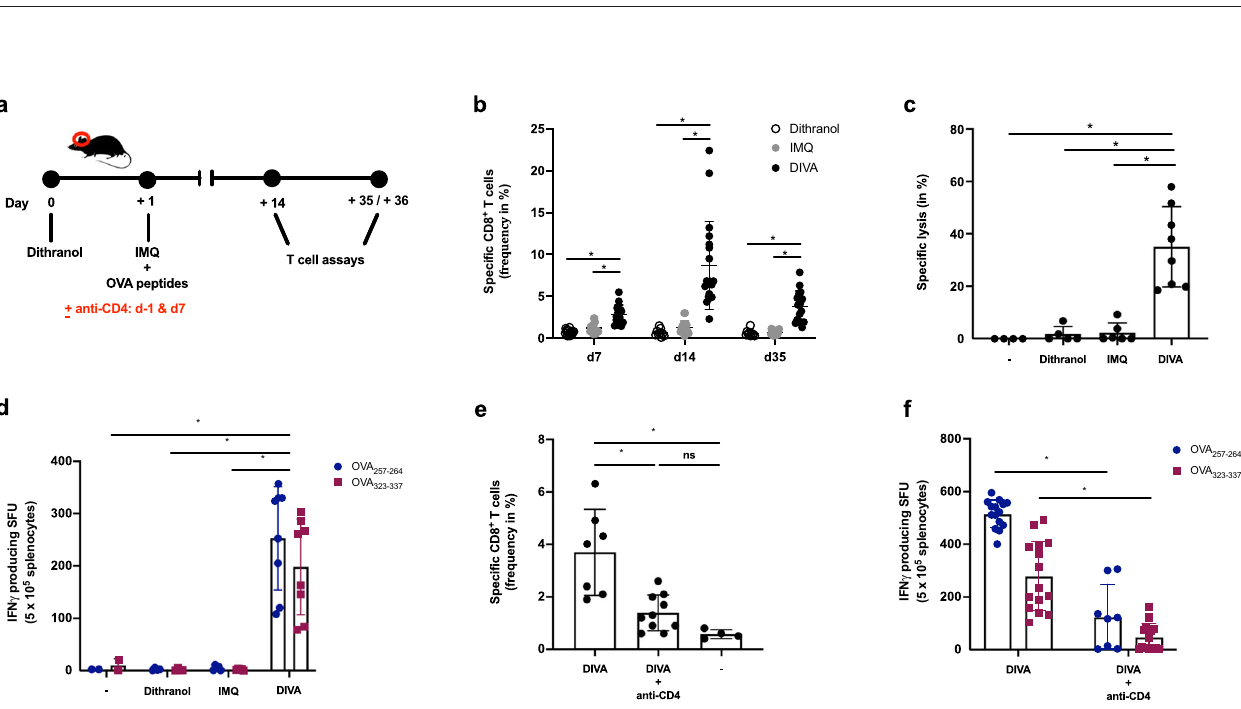
Fig. 2 DIVA generates memory CD8 + and CD4 + T cell responses. a Schematic overview of the DIVA protocol for the generation of a memory immune response. C57B6/J wildtype mice were immunized on both ears with dithranol (day 0) and IMQ together with OVA 257 – 264 & OVA 323 – 337 (stirred in of fi cinal cremor basalis, day 1) on 2 consecutive days, treated with the single agents or left untreated (untreated control). b The frequency of OVA 257 – 264 speci fi c CD8 + T cells in the blood was assessed on day 7, 14, and 35 ( n = 9 – 19). c On day 36, the in vivo cytolytic activity was estimated 20 h after transfer of peptide-loaded, CFSE-labeled target cells ( n = 4 – 8) (Supplementary Fig. 1c). d Splenocytes were ex vivo restimulated with either OVA 257 – 264 or OVA 323 – 337 peptide and IFN- γ -producing cells were analyzed by ELISpot assays on day 36. Bars represent mean and SD of data collected from at least two independent experiments. e , f The frequency of OVA 257 – 264 -speci fi c CD8 + T cells ( e ) and IFN- γ producing cells ( f ) after restimulation with OVA 257 – 264 or OVA 323 – 337 were quanti fi ed in splenocytes on day 35 after DIVA with or without CD4 T cell depletion (500 µg GK1.5 i. p. as indicated). * p < 0.05 by one-way ANOVA with Bonferroni ’ s post hoc test, fl ow cytometry gating strategy in Supplementary Fig.